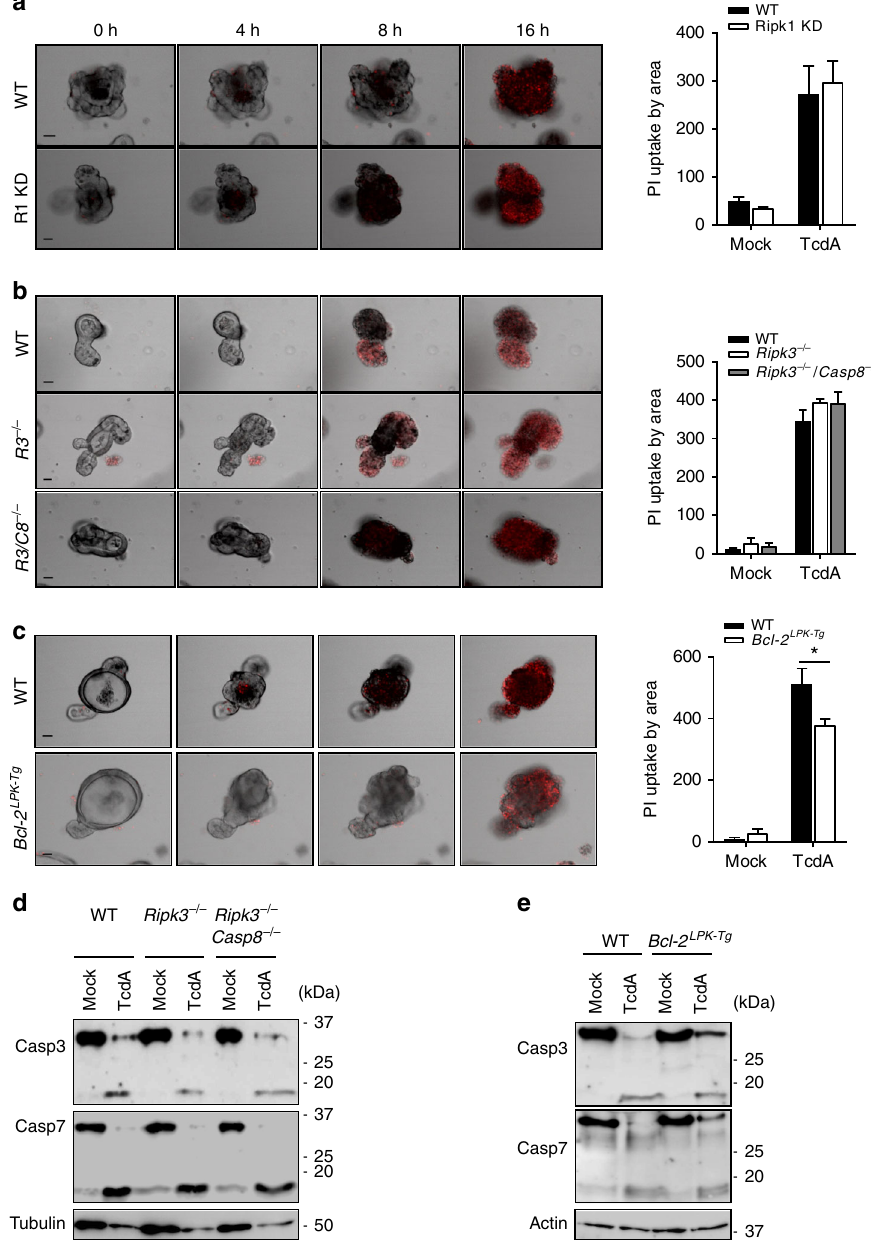
Fig. 4 RIP kinases and caspase-8 are dispensable, whereas Bax/Bak pores contribute to TcdA-induced IEC killing. a – c Primary intestinal organoids from wild-type (WT) and a Ripk1 D138N (RIPK1 kinase dead), b Ripk3 − / − and Ripk3 − / − Casp8 − / − or c Bcl-2 LPK-Tg mice were stimulated with TcdA and PI incorporation analyzed by live-imaging for 16 h. Graphs correspond to PI quanti fi cation plotted by organoid area. Scale bars: 30 µ m. d , e Cell lysates from primary intestinal organoids of d Ripk3 − / − and Ripk3 − / − Casp8 − / − or e Bcl-2 LPK-Tg stimulated with TcdA were prepared and immunoblotted for caspase-3, caspase-7 and tubulin or β -actin. Data are representative of 3 independent experiments. Data are shown as mean ± SD and were analyzed with 2-way ANOVA. * P < 0.05, ** P < 0.01, and *** P <